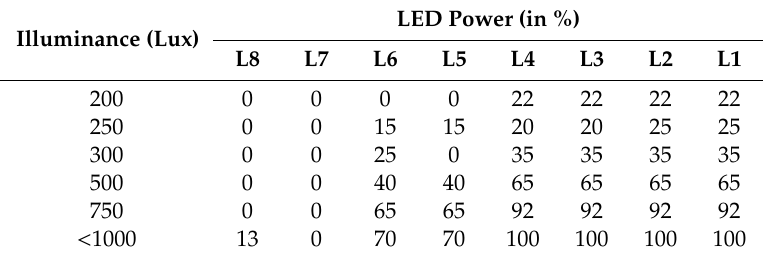
Table 4. Simulation results from sub-scenario B, 9:00 a.m., 5 June 2019.